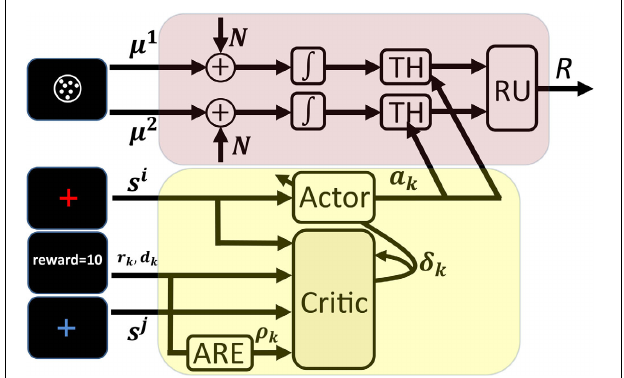
FIGURE 7 | Schematics of the proposed model of learning the optimal decision thresholds. All frames of a trial in Figure 1 are shown here as the input to different components of the model. The cue presented at the beginning of the trial (the red cross-hair here) determines the current state, s k , and acts as the input to the actor. Based on s k and the current policy the actor chooses a value a for the decision thresholds of the information accumulators. The arrows from the output of the actor to the threshold units in the accumulators (denoted as TH in the figure) show that the decision thresholds are set by the actor. The noisy information accumulation is represented in the figure by two channels in which the noise N is added to the signals μ i and passed through integrators. This noisy accumulated information is sent to the threshold units and finally to the response unit (RU in the figure) that determines which accumulator has finished processing first. After responding, the model receives the feedback which is the inputs to the critic. Other inputs of the critic are the cue presented in the next trial (which determines the next state s k + 1 ) and the estimate of the average reward rate. The ARE unit in the figure receives the reward as its input and computes an estimate of the average reward rate using equation 19. Finally, the critic computes the TD error signal through equation 17 and uses it to update both the estimate of state values and the